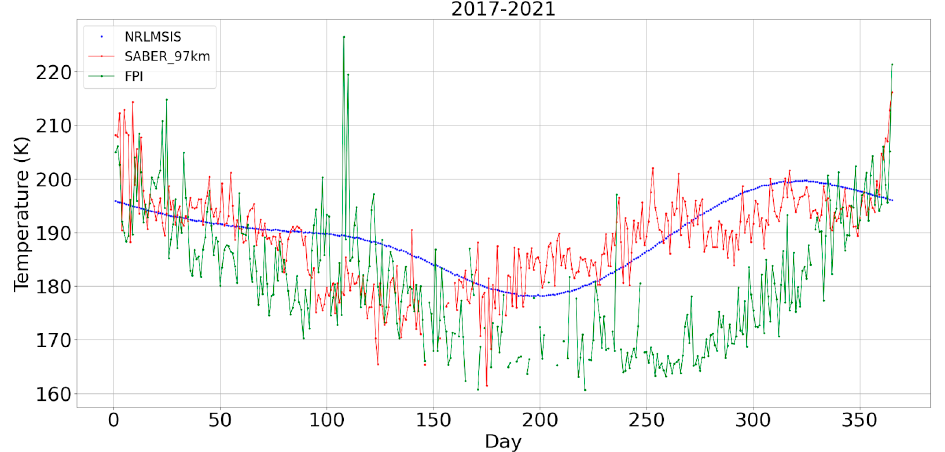
Figure 3. Annual average effective temperature from 2017 to 2021. SABER (red), FPI (green) and NRLMSIS model (blue).